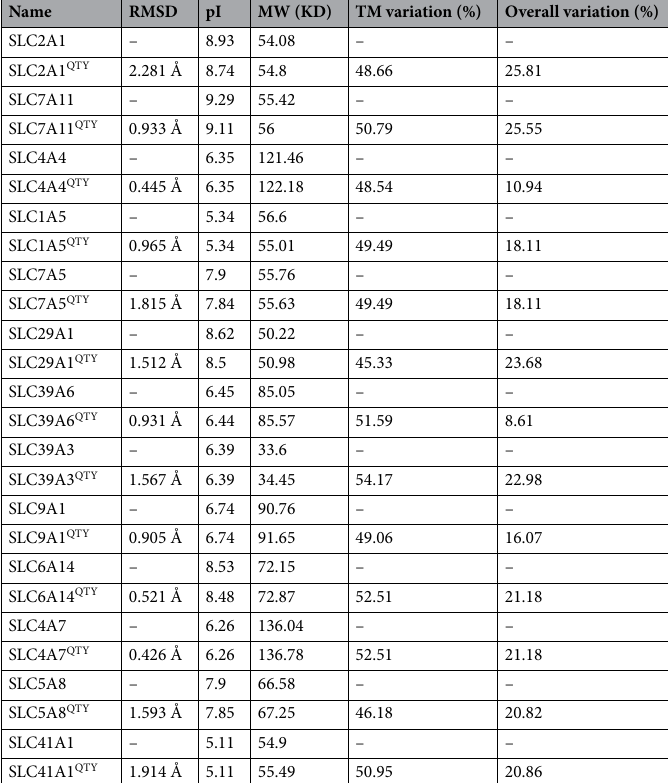
selects 3 neutrally polar amino acids: glutamine, threonine and tyrosine to replace 4 hydrophobic amino acids leucine, isoleucine, valine and phenylalanine. After applying the QTY code, the hydrophobic amino acids in the transmembrane segments are replaced by Q, T, and Y, therefore the transmembrane segments have significantly reduced hydrophobicity. For example, SLC39A3 and SLC29A1 differ > 54 and > 45% from their water-soluble